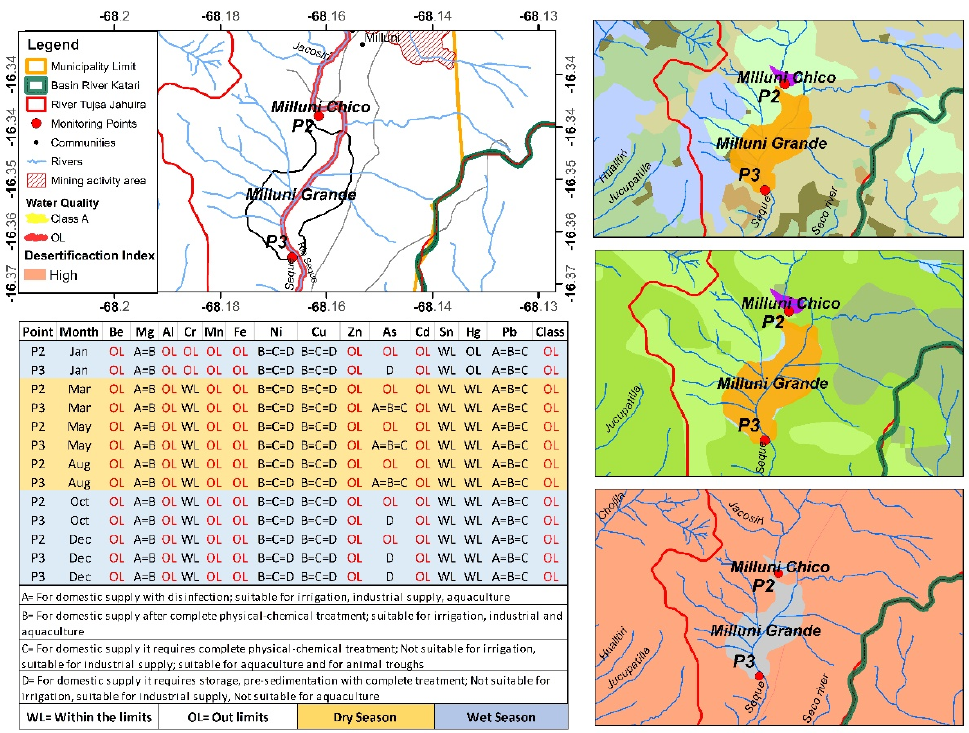
Figure 6. Water quality classification according to parameters monitored in P2 and P3—Milluni Ba- sin .